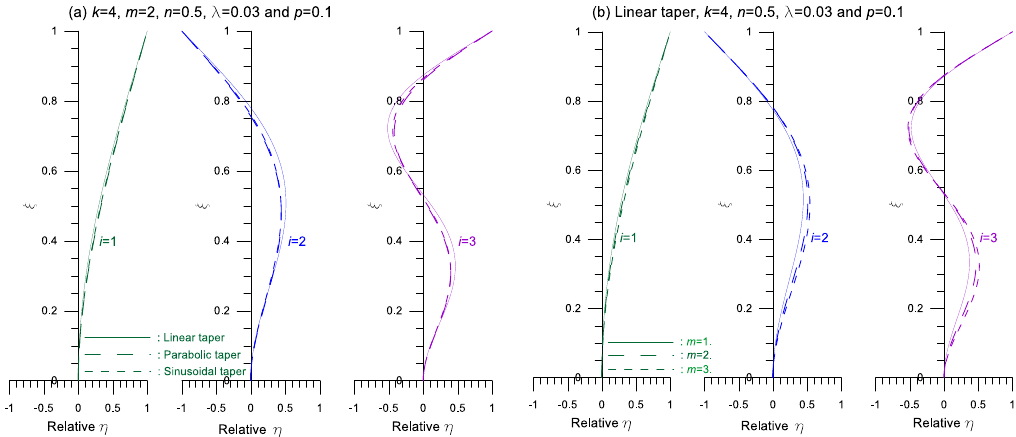
Figure 8. Examples of mode shape ( ξ i , η i ) : ( a ) by taper type; ( b ) by modular ratio m.